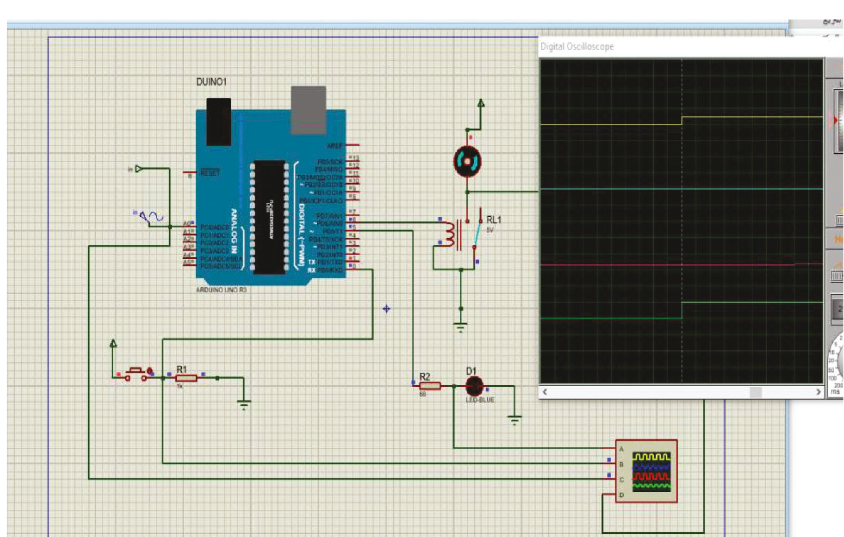
Figure 16: The system identification.